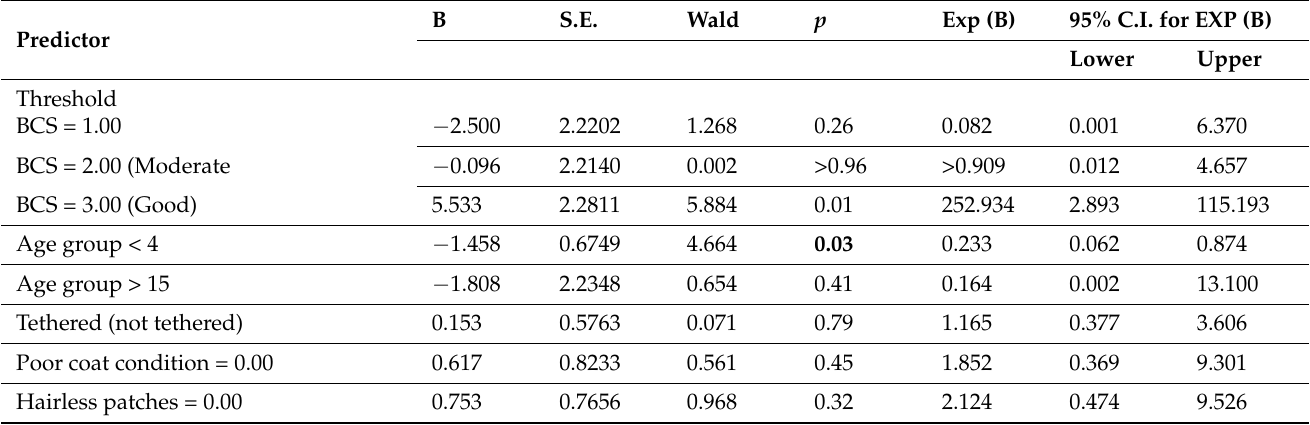
Table 3. Ordinal logistic regression predicting horse body condition ( n = 101). Significant results are bolded ( p < 0.05), degrees of freedom =